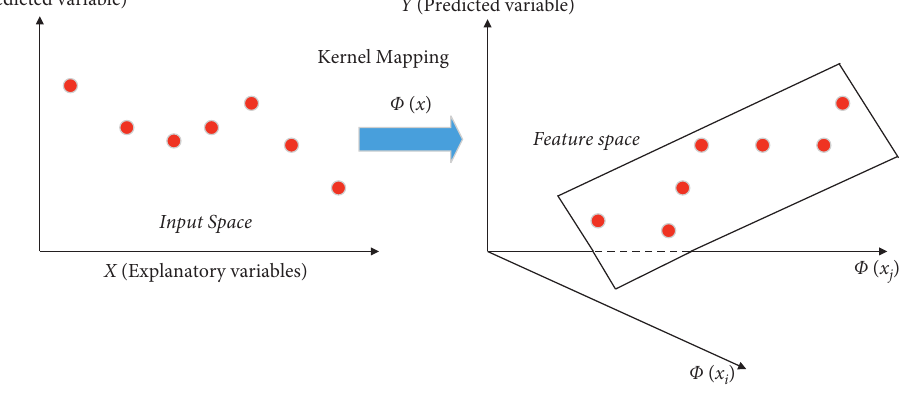
Figure 5: The LSSVR learning